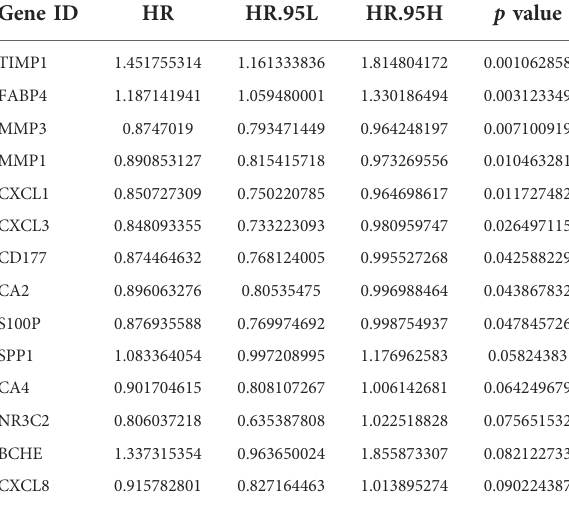
TABLE 3 The genes identi fi ed by univariate